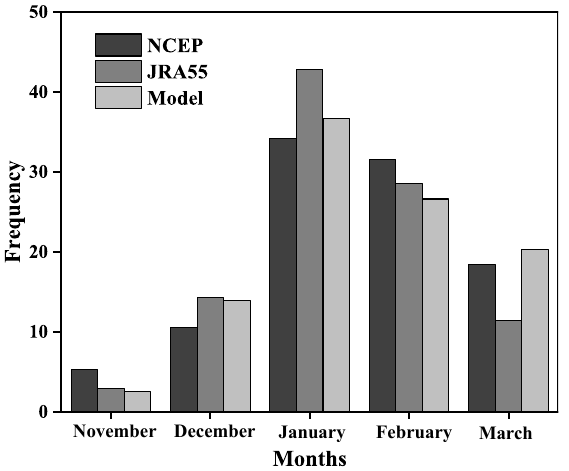
Figure 1. The frequency distribution (units: percentage) of SSW events in each wintertime month in the NCEP/NCAR ( black ) and JRA55 reanalyses ( dark grey ) and CESM1-WACCM ( light grey ).